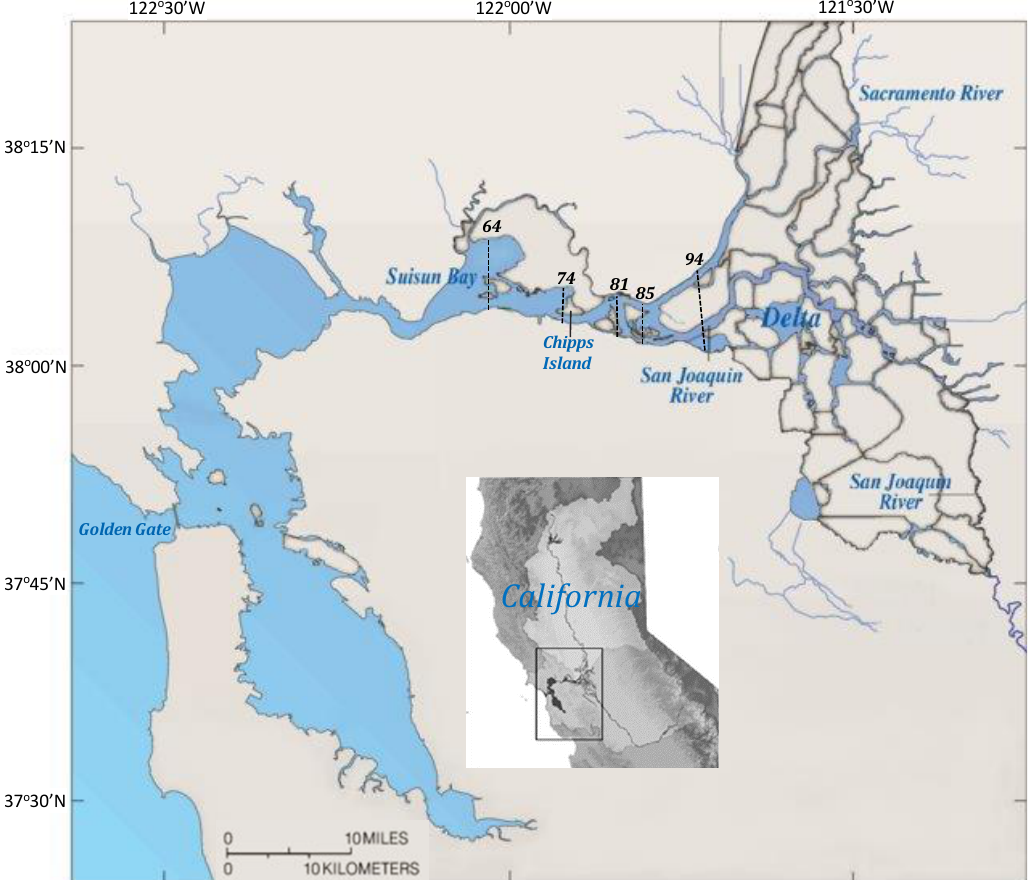
Figure 1. The San Francisco Estuary showing the Suisun Bay and Delta regions in the upper estuary. Dashed lines denote the positions of the 2 psu isohalines (X2) considered in community models (74, 81, and 85 km) and the range of the average X2 position in September–October (64–94 km) from 1967 to 2017. Map adapted from [24].